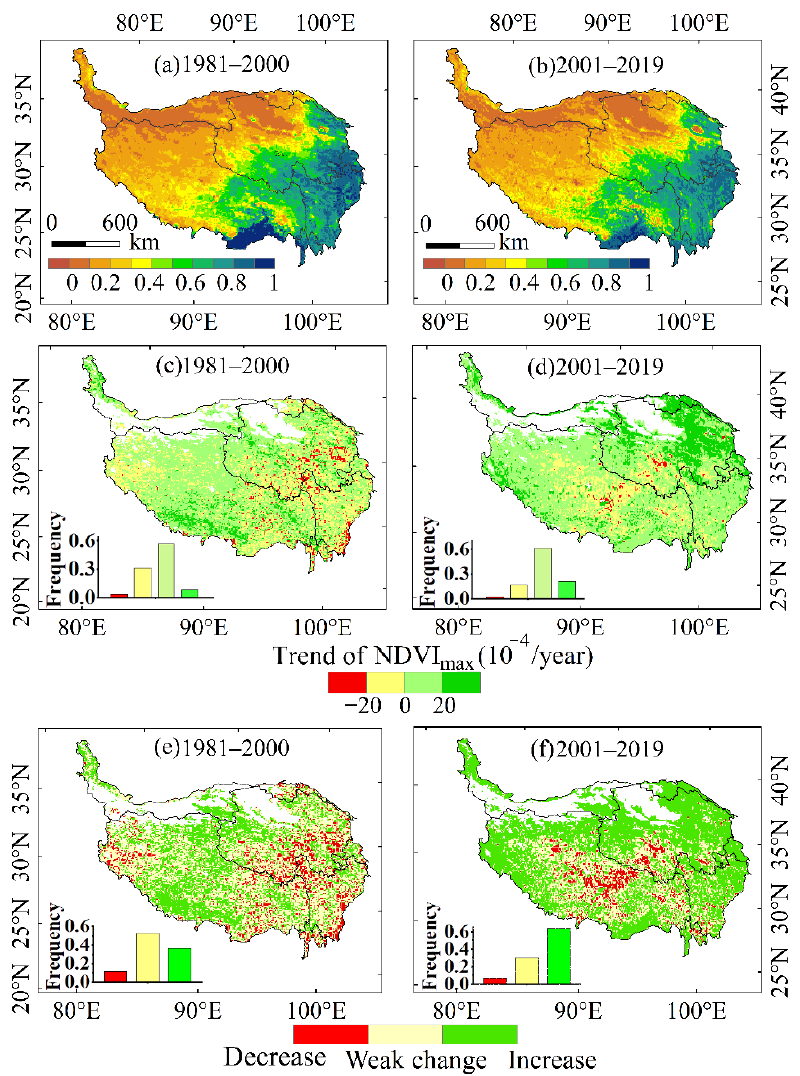
Figure 2. The spatial distribution of NDVI max ( a ). 1981–2000; ( b ). 2000–2019, the trend of NDVI max